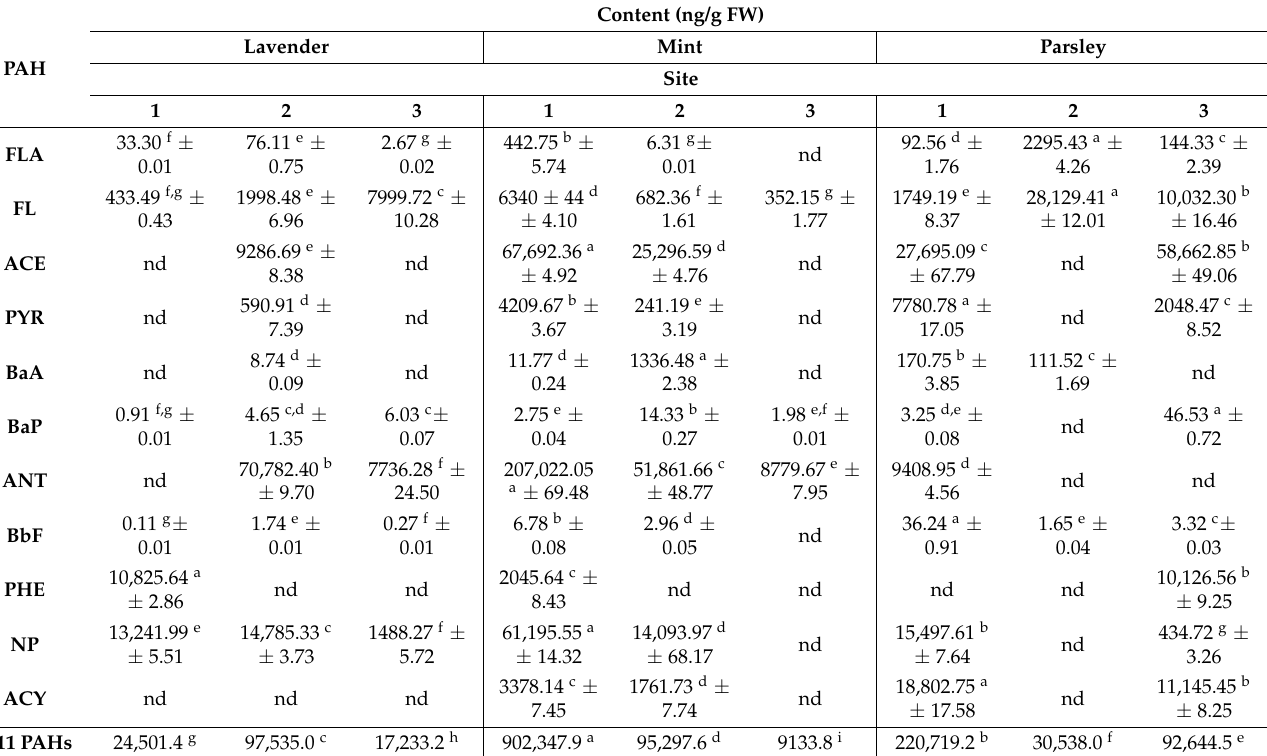
Table 1. The concentration of PAHs in aerial parts of plants (buds of lavender, shoots